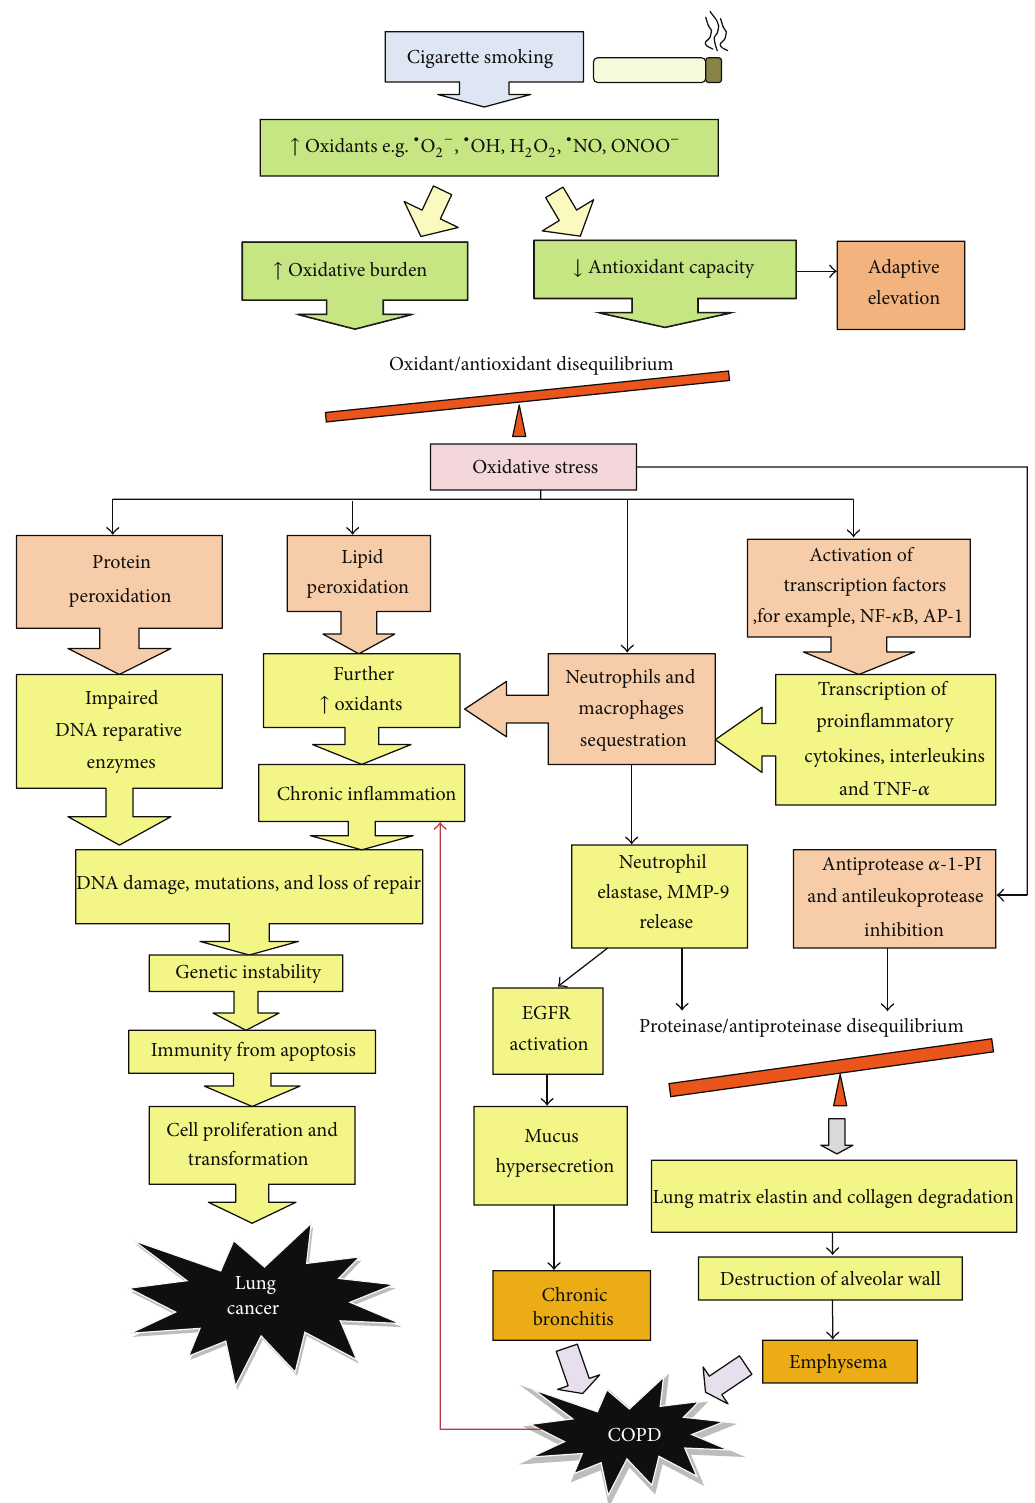
Figure 2: Smoking is the major cause of COPD and lung cancer. Oxidants in cigarette smoking are not only a direct cause of lung cancer by DNA damage through protein and lipid peroxidation but also an indirect cause by triggering inflammation. While products of recruited inflammatory mediators cause COPD by degrading lung matrix and promoting mucus hypersecretion, COPD is itself a disease of chronic inflammation which promotes